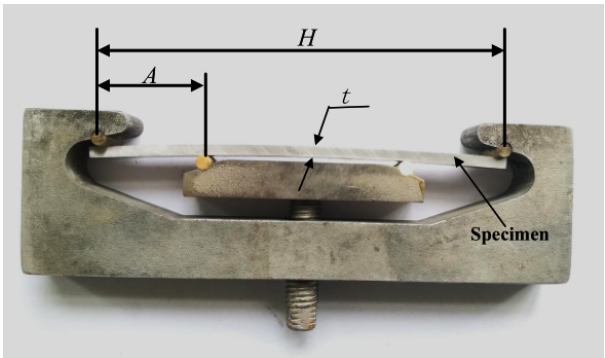
Figure 1. Schematic presentation of the four ‐ point bending loading method.